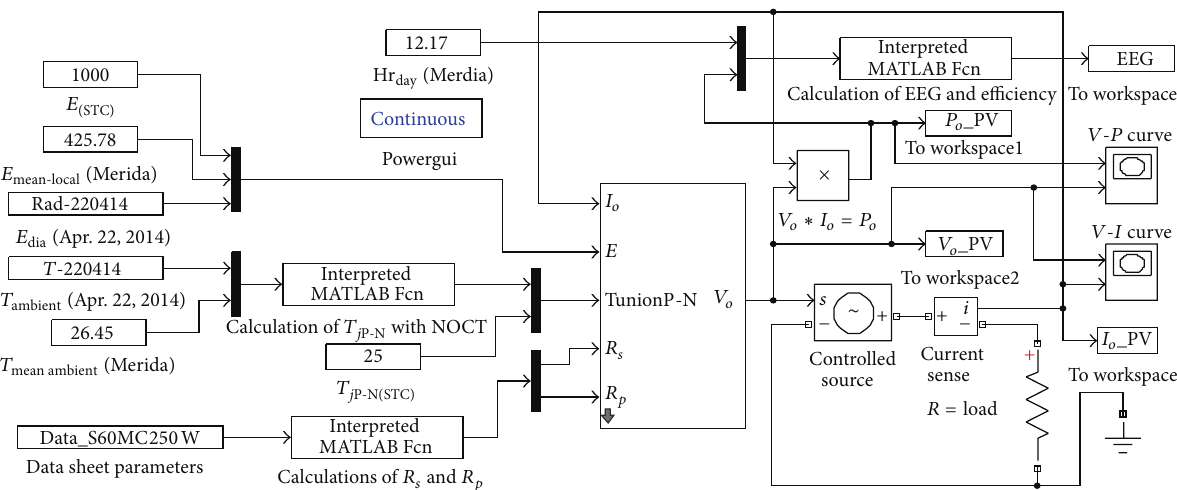
Figure 7: Implementation of proposed mathematical method in MATLAB Simulink.